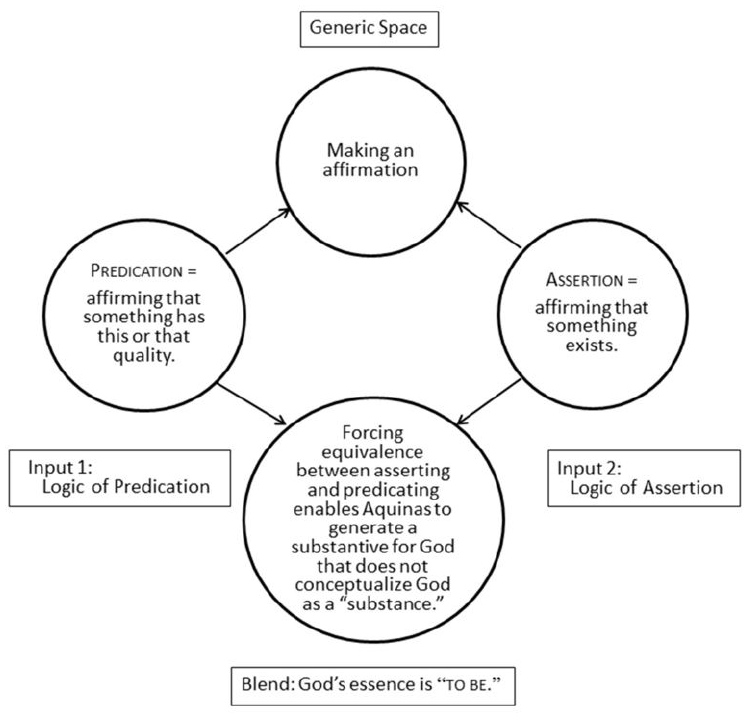
Figure 7: Cognitive mapping of Aquinas‘s blend: God‘s essence is ‟to be” As is the case often with conceptual blends, the tectonic force of the mapping is not necessarily conscious. It is likely that Aquinas was not himself conscious of the complex cognitive processes motivating his conceptions and